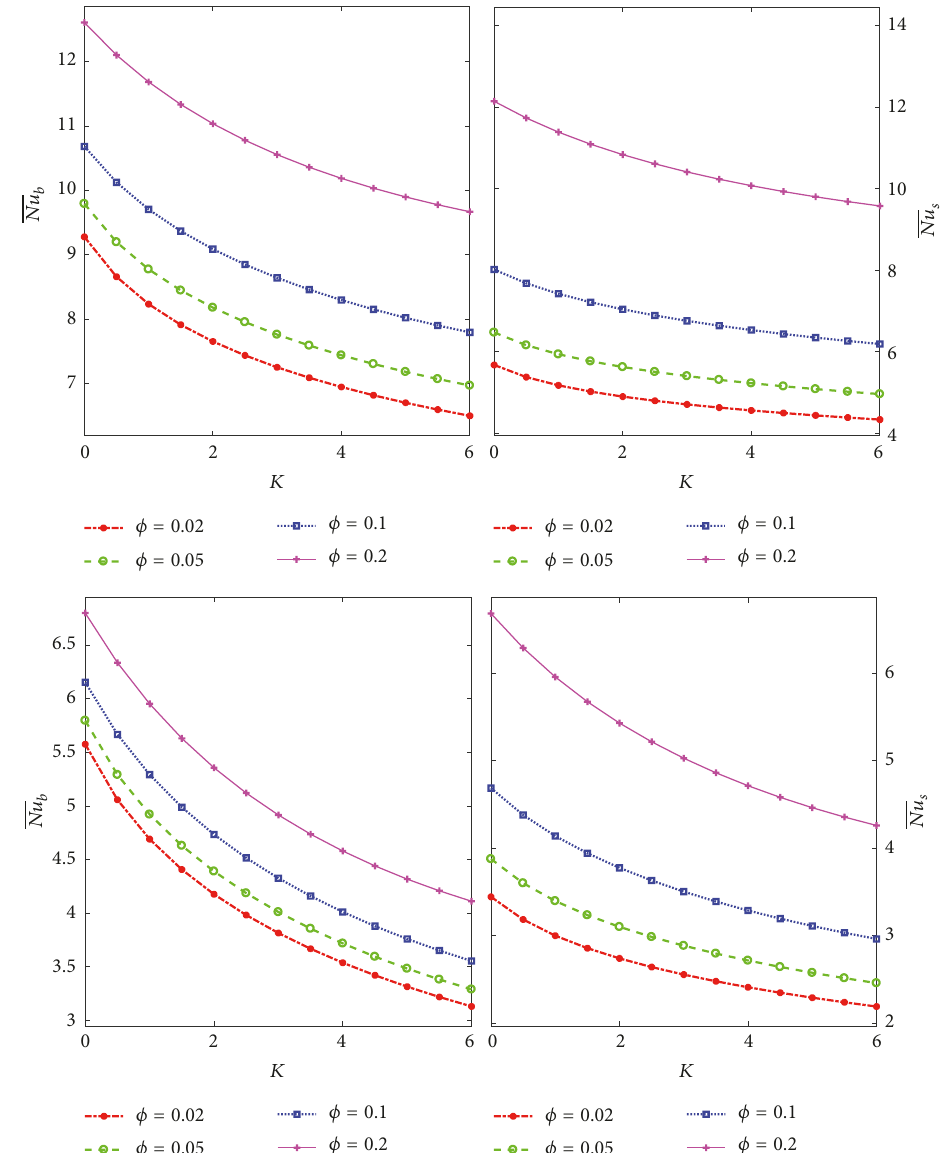
Figure 6: Variations of average Nusselt number at bottom (left) and average Nusselt number at side (right) against K by varying 𝜙 for continuous case 1 (top) and discontinuous heating case 2 (bottom) at 𝐺 = 1.0